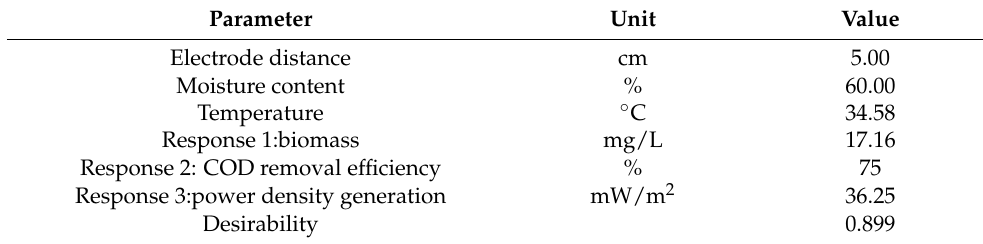
Table 4. Optimal conditions suggested by Design Expert 13 software.